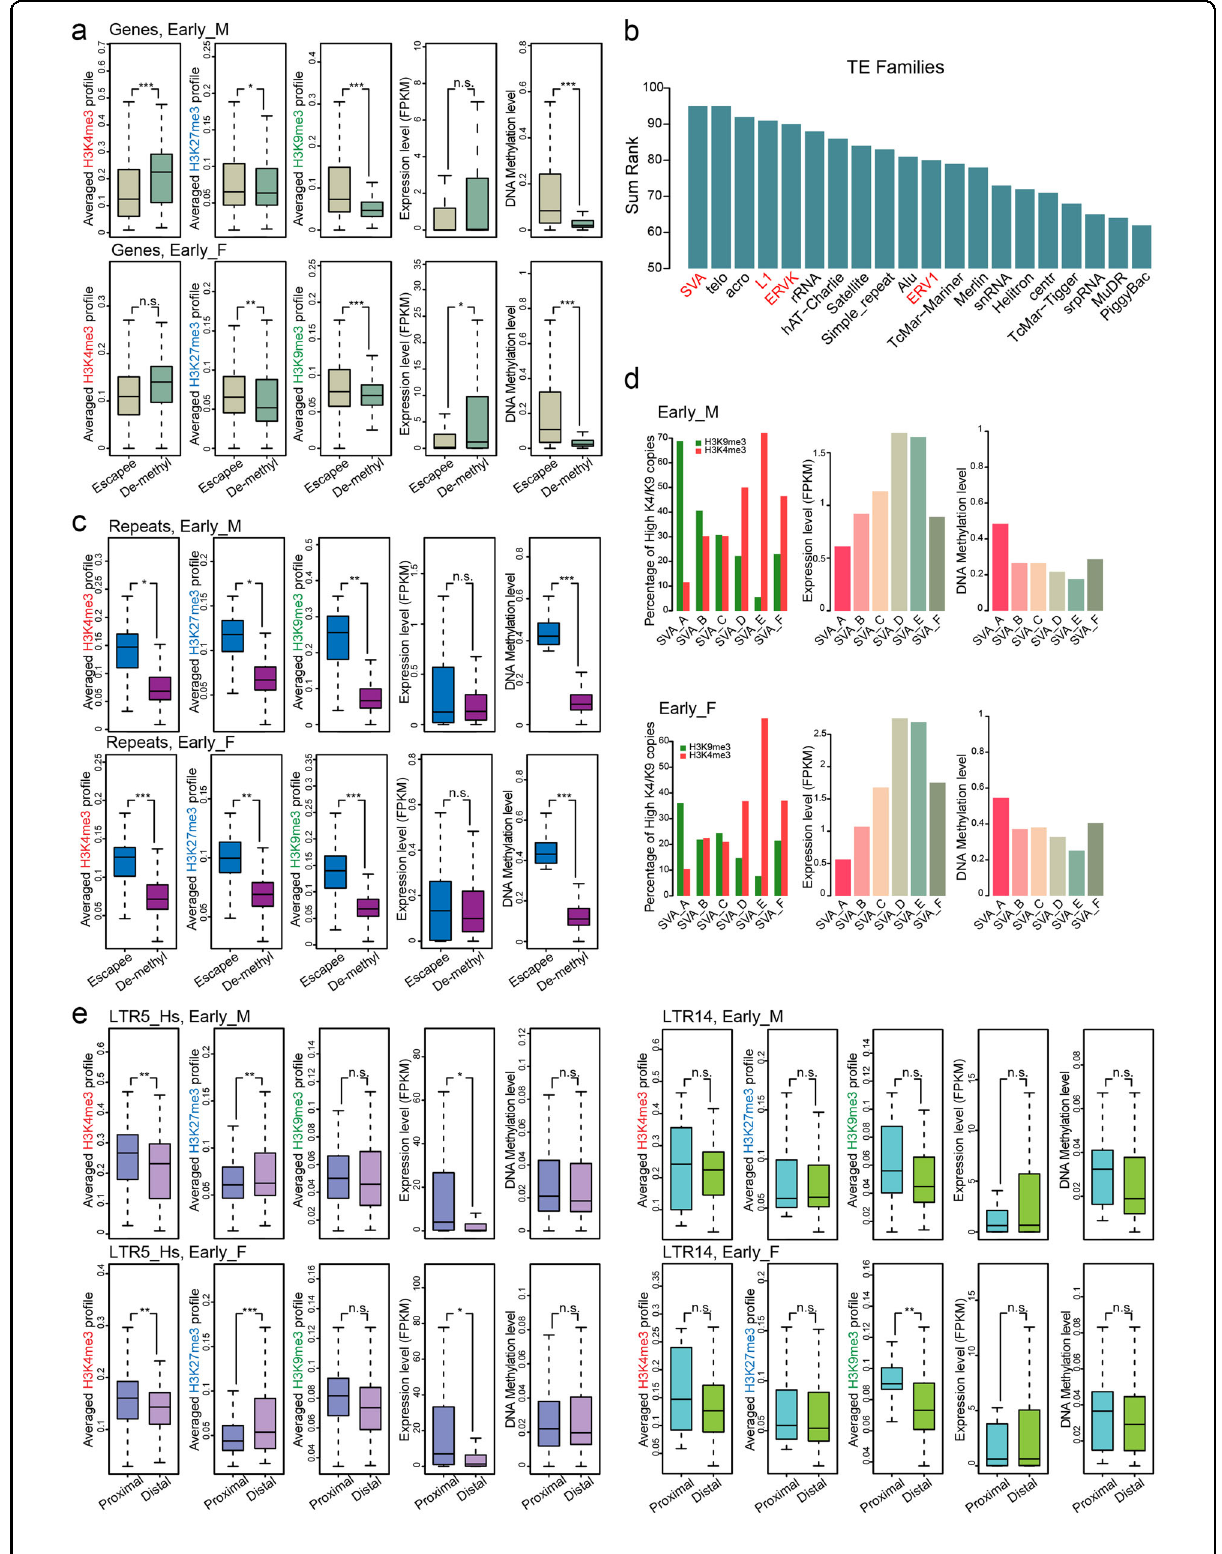
Fig. 4 (See legend on next